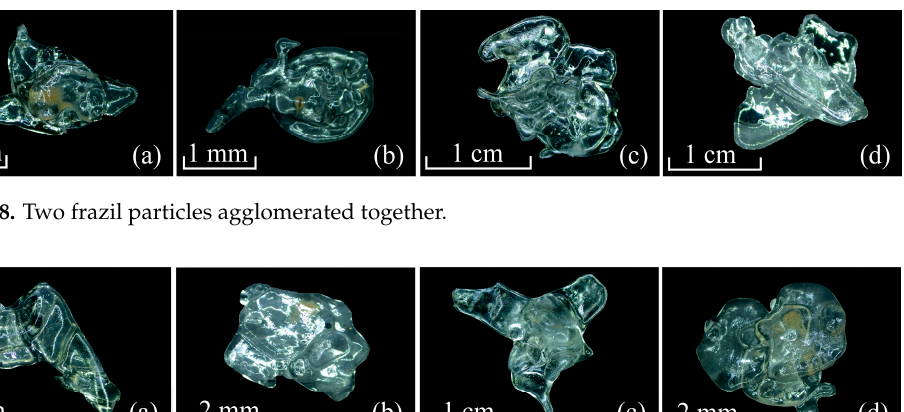
Figure 7. Distribution of the characteristic parameters of granular frazil particles: ( a ) diameter distribution; ( b ) roundness distribution.